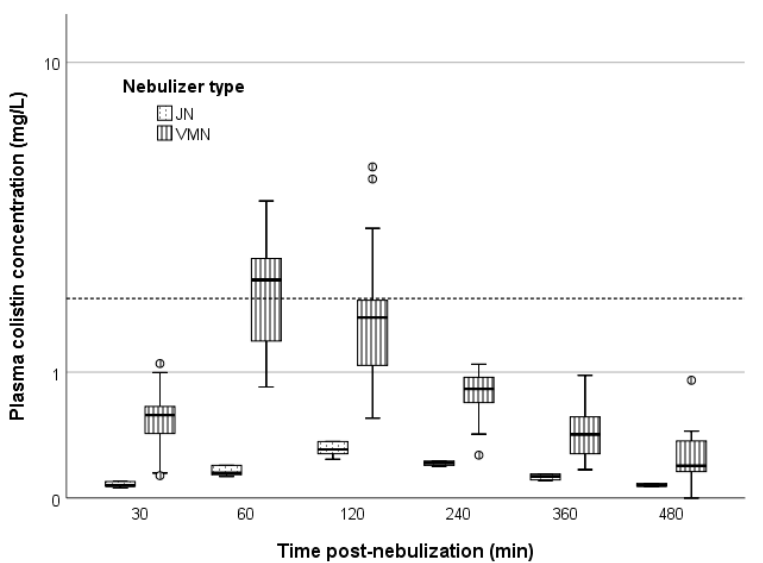
Figure 3. Colistin plasma concentration at 30, 60, 120, 240, 360 and 480 min after inhalation of 2 million international units of colistimethate sodium via jet nebulizers (dotted boxplot) and vibrating mesh nebulizers (vertical line boxplot). The dashed line represents the average steady-state plasma colistin concentration (2 mg/L) associated with the occurrence of acute renal failure according to [21]. Circles represent outliers. JN: jet nebulizers, VMN: vibrating mesh nebulizers. Table 2. Pharmacokinetic/pharmacodynamic (PK/PD) parameters in epithelial lining fluid (ELF) and in plasma after inhalation of 2 million international units of colistimethate sodium via jet neb- ulizer (JN) or vibrating mesh nebulizer (VMN). Values are expressed as frequencies or medians and interquartile ranges, unless otherwise specified. Comparisons with statistically significant differences are depicted in bold.